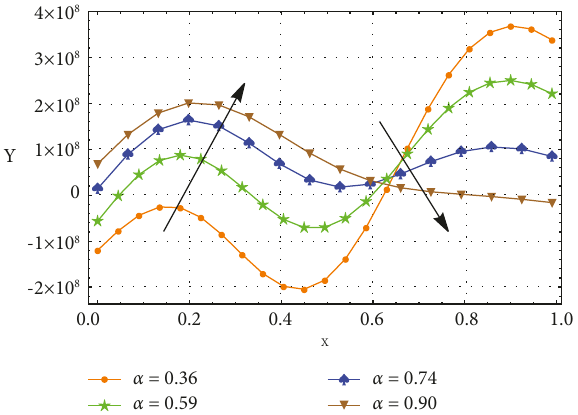
Figure 10: Effect of distinct values of α on wave profile in Example 3 when ρ � 5 and τ � 3.